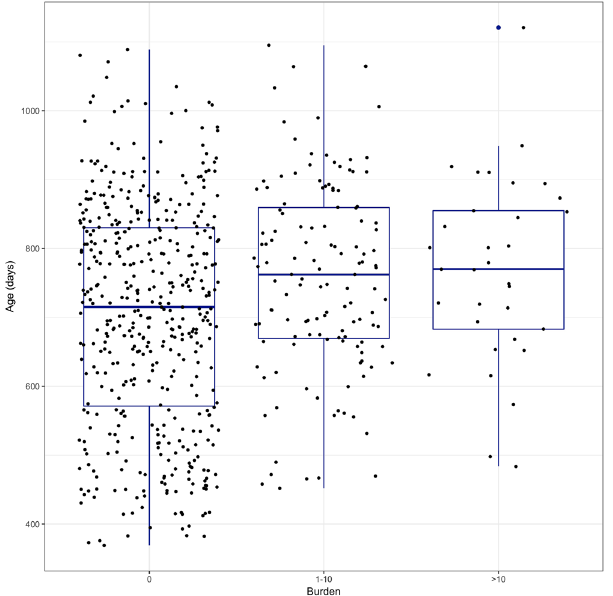
Figure 4. Distribution of cattle age at slaughter by burden category. Figure shows box plots and actual values of cattle age at slaughter for each burden category (n = 619). Slaughter age is higher in animals with a burden of more than 0, but the slaughter age distributions of animals of burden 1–10 and > 10 are very